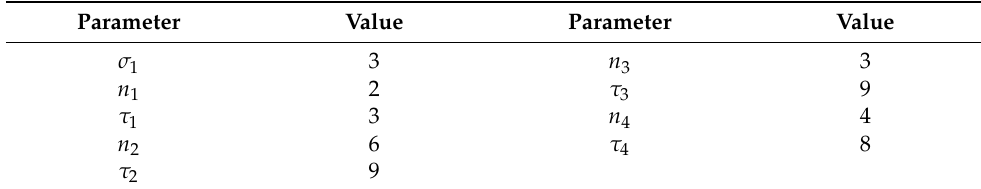
Table 1. The parameter of the proposed model. Parameter